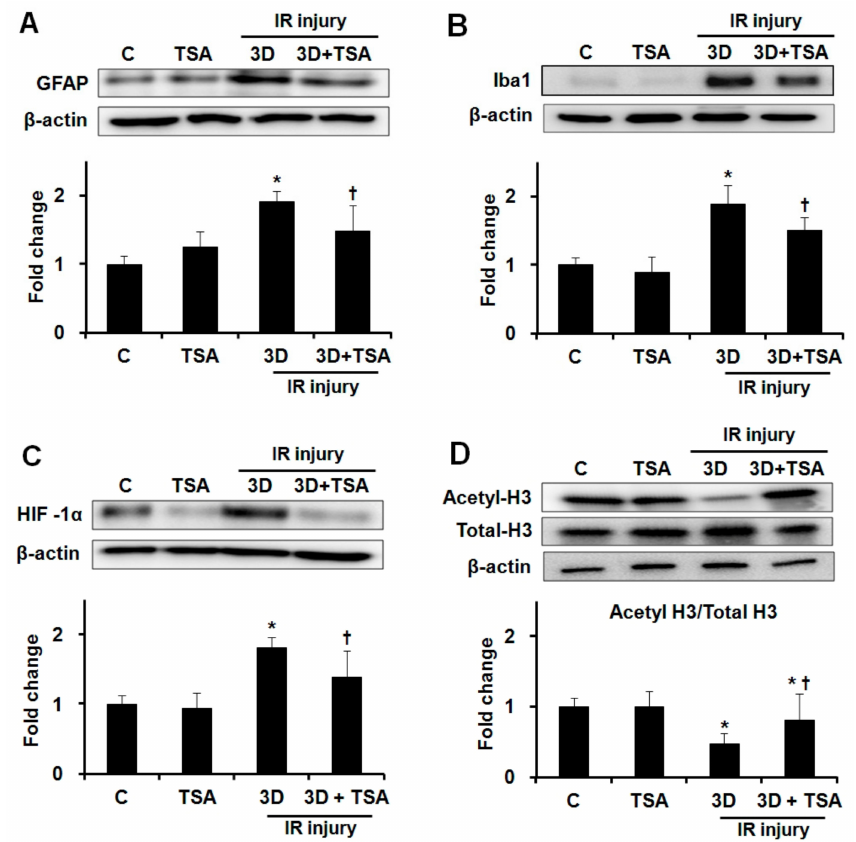
Figure 2. E ff ect of TSA on expression of GFAP, Iba1, HIF-1 α , and acetyl-H3 in ischemic retinas. Representative cropped western blots depicting GFAP, Iba1, HIF-1 α , acetyl-H3, and total-H3 protein levels, respectively. Full size images are presented in Supplementary Figure S2. TSA treatment significantly inhibited increased expression of GFAP ( A ), Iba1 ( B ), and HIF-1 α ( C ) in ischemic retinas after IR injury. TSA treatment prevented the downregulation of acetyl-H3 expression in ischemic retinas relative to saline treatment after IR injury ( D ). Relative chemiluminescence intensity for each protein band was normalized using β -actin as a calibrator. Error bars, SD ( n = 10 retinas / group). * p < 0.01 compared to the control group. † p < 0.01 compared to the saline-treated 3D group. All comparisons were performed using one-way ANOVA with post hoc Bonferroni’s